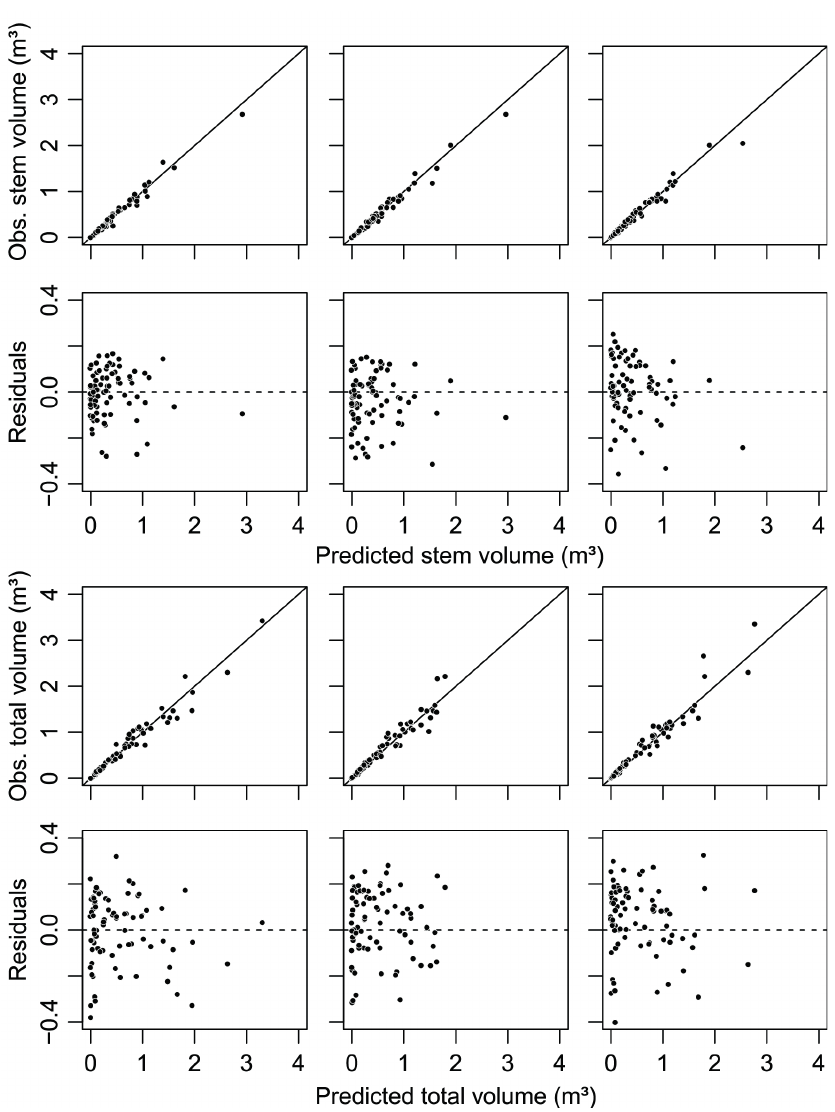
Figure 2 - Observed vs. predicted values generated by model 10 for stem and total volume. The plots are based on three independent iterations of the model fitting